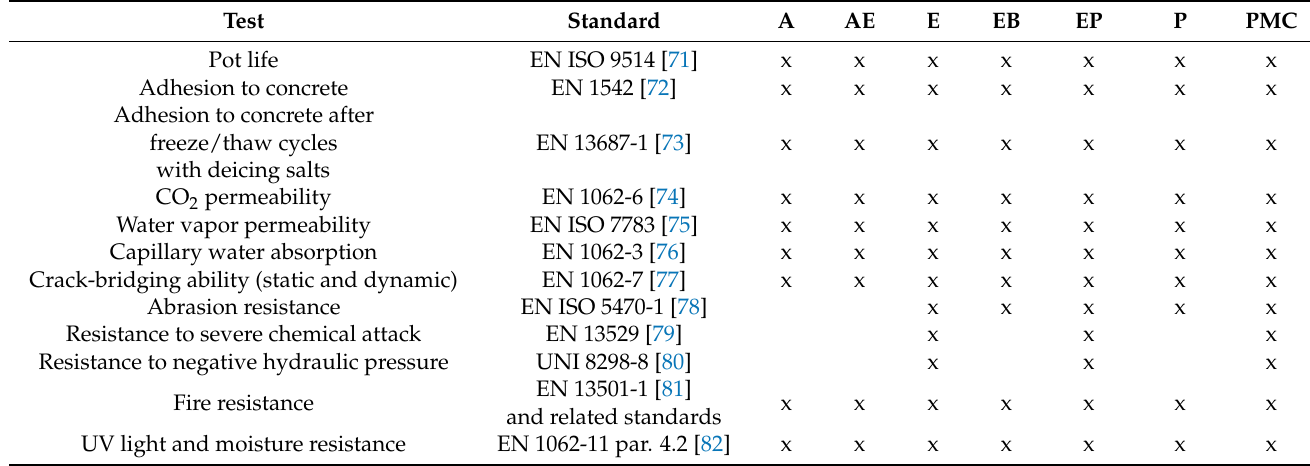
Table 3. Details on the experimental tests carried out on